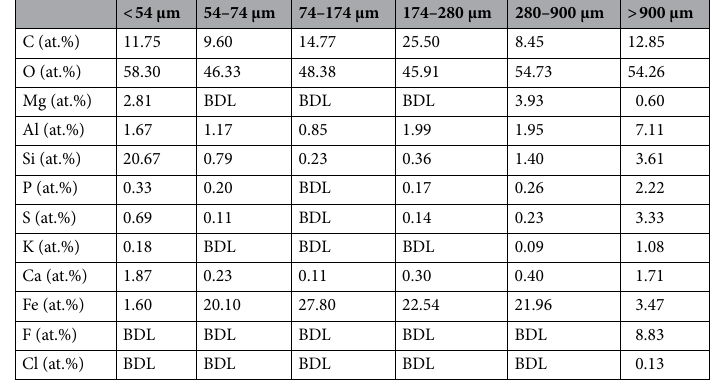
Table 5. EDX analysis of fly ash samples with different particle sizes. BDL below detection limit.